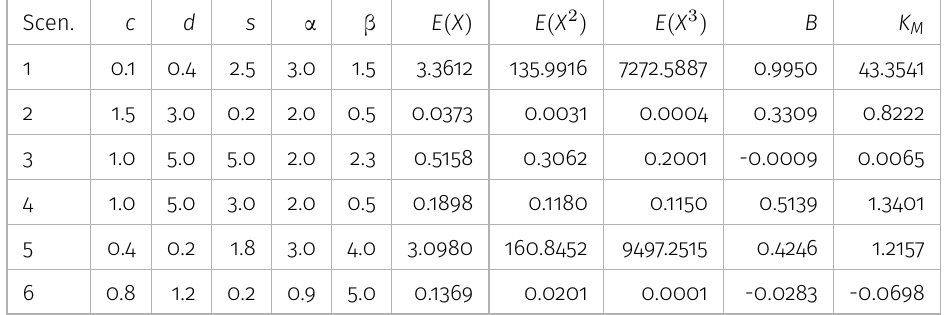
Table II. First three moments and B and K M for some scenarios of the WBXII distribution.